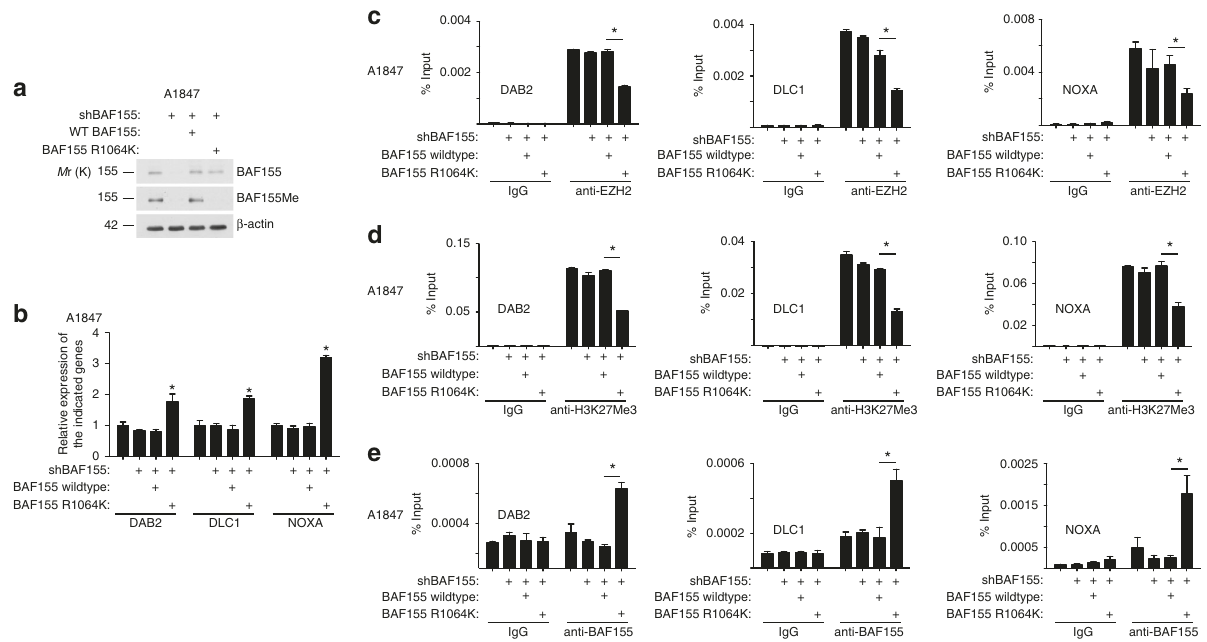
Fig. 5 CARM1-mediated R1064 BAF155 methylation displaces BAF155 with EZH2 at the promoters of EZH2/BAF155 target genes. a CARM1-expressing A1847 cells were infected with a lentivirus encoding shBAF155 targeting the 3 ′ untranslated region (UTR) of the human BAF155 gene together with a retrovirus encoding wild-type BAF155 (WT) or a BAF155 R1064K mutant. Expression of BAF155 and BAF155Me was determined by immunoblot. β -actin expression was used as a loading control. b Same as a , but examined for the expression of the indicated BAF155/EZH2 target genes by qRT-PCR. * P < 0.001. c – e The indicated cells were subjected to ChIP analysis using anti-EZH2 ( c ), anti-H3K27Me3 ( d ), or anti-BAF155 ( e ) antibodies. An isotype- matched IgG was used as a negative control. ChIP products were subjected to qPCR analysis using primers speci fi c for the promoter regions of the human DAB2 , DLC1 , and NOXA genes. Error bars represent SEM. P -values are from two-tailed t